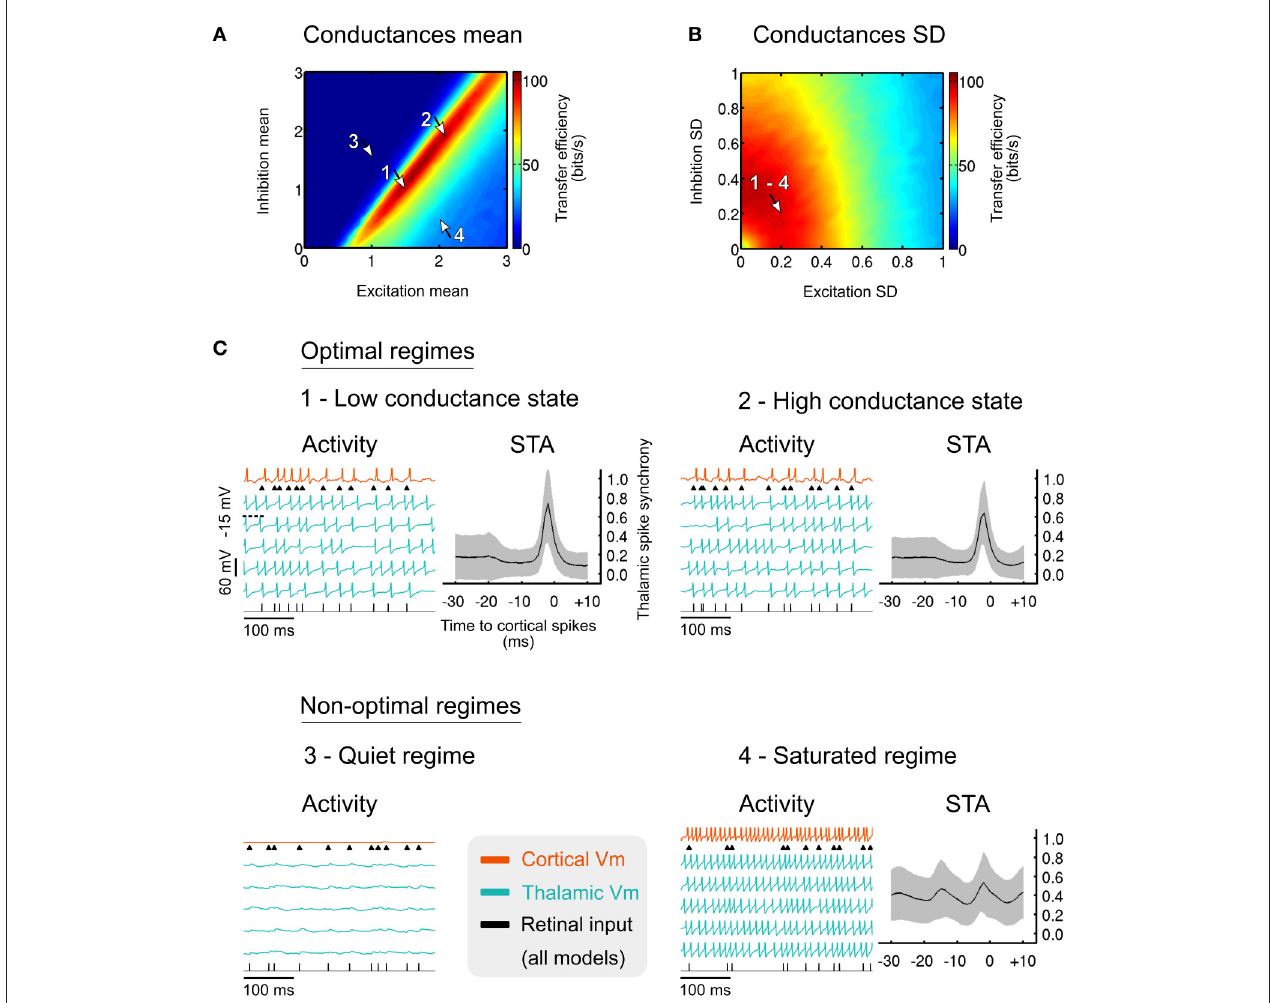
FIGURE 6 | (A) Effect of the cortical excitatory and inhibitory mean input conductances on the sensory transfer efficiency. Mean conductances were normalized relative to the resting conductance of the thalamic cells. Arrows indicate specific operating regimes illustrated in (C) . The normalized conductance standard deviations were normalized relative to their respective means, and set to 0.2 for both excitation and inhibition. (B) Similar to (A) for the standard deviation of the excitatory and inhibitory conductances. The normalized conductance means were set to 1.5 for the excitation and 1.0 for the inhibition. (C) Membrane voltage traces for the four specific regimes denoted by the arrows in (A,B) . The thalamic spike synchrony was measured with cortical spike-triggered average. The number of thalamic spikes evoked in the corresponding regimes was averaged using a bin size of 1 ms and was then normalized to the total number of TC cells. Grayed areas represent the standard deviation of the counts across all cortical spikes ( n > 10 3 in every bin). Modified from Béhuret et al. (2013).